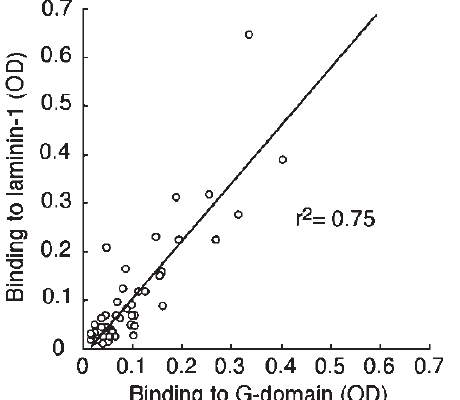
FIGURE 6 Cross-reactivity of IgG anti-laminin-1 autoantibodies from sera of patients with infertility to the intact laminin-1 molecule and to laminin- a 1 chain G domain.